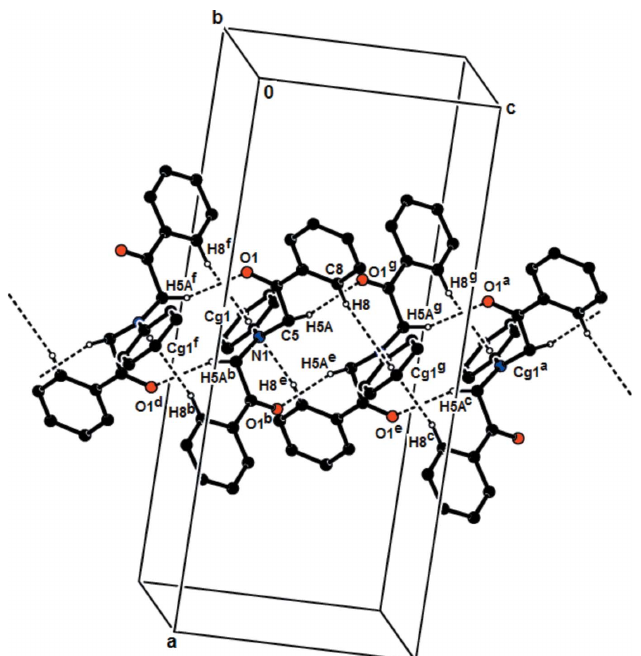
Figure 2 A general view of the intermolecular C—H (cid:2)(cid:2)(cid:2) O hydrogen bonds, and C—H (cid:2)(cid:2)(cid:2) (cid:2) interactions of the title compound. The hydrogen atoms not involved in the hydrogen bonds have been omitted for clarity. Symmetry codes: ( a ) x , y , z + 1; ( b ) 1 (cid:4) x , y , 1 1 (cid:4) y , (cid:4) z ; ( e ) 1 (cid:4) x , 1 (cid:4) y , 1 (cid:4) z ; ( f ) x , 1 (cid:4) y , (cid:4) 1